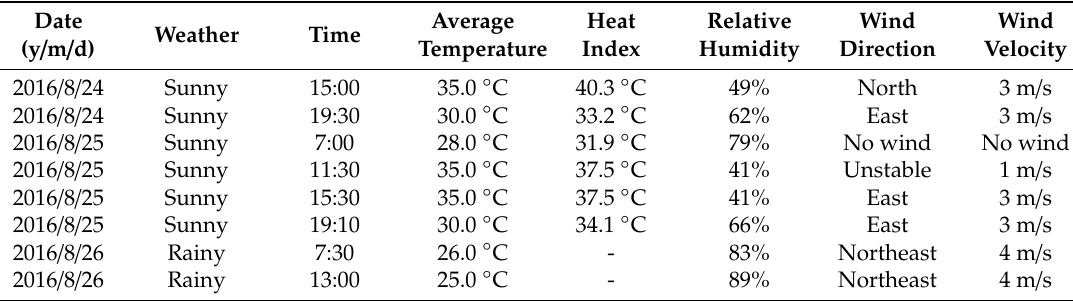
Table 1. Measurement time and weather conditions during investigation [17].